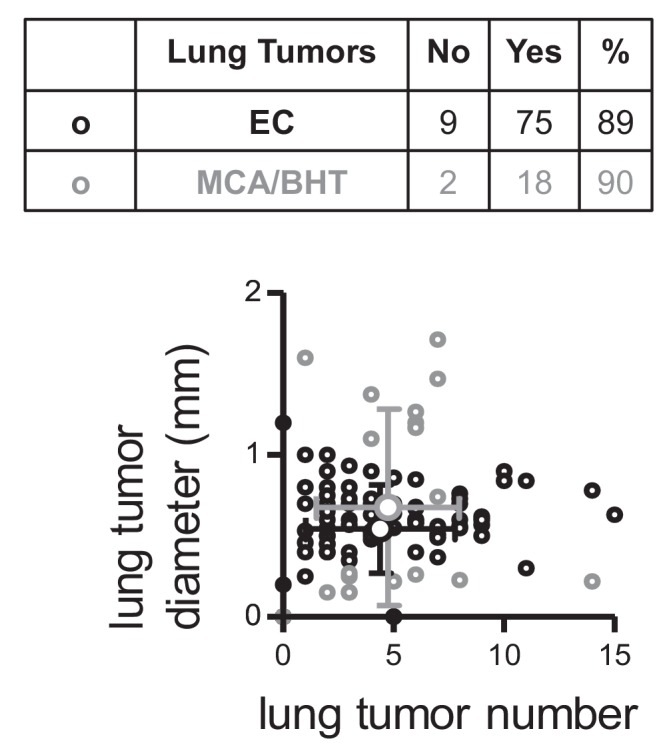
Lung tumors induced in C57BL/6 mice by two carcinogen regimens.Eighty-four C57BL/6 mice received ten weekly intraperitoneal injections of 1 g/Kg urethane (ethyl carbamate, EC) initiated at six weeks of age and lungs were examined six months after the first urethane injection (black font and symbols). Twenty C57BL/6 mice received four weekly intraperitoneal injections of 15 mg/Kg 3-methyl-1,2-dyhydrobenzo[j]aceanthrylene (MCA) followed by eight weekly intraperitoneal injections of 200 mg/Kg butylated hydroxytoluene (BHT) and lungs were examined six months after the first MCA dose (gray font and symbols). Table shows tumor incidence and graph shows tumor number versus mean tumor diameter. Each small circle represents one mouse and each large circle with error bar the means for each carcinogen regimen.10.7554/eLife.45571.018Figure 1—figure supplement 10—source data 1.Quantification of data shown in Figure 1—figure supplement 10.